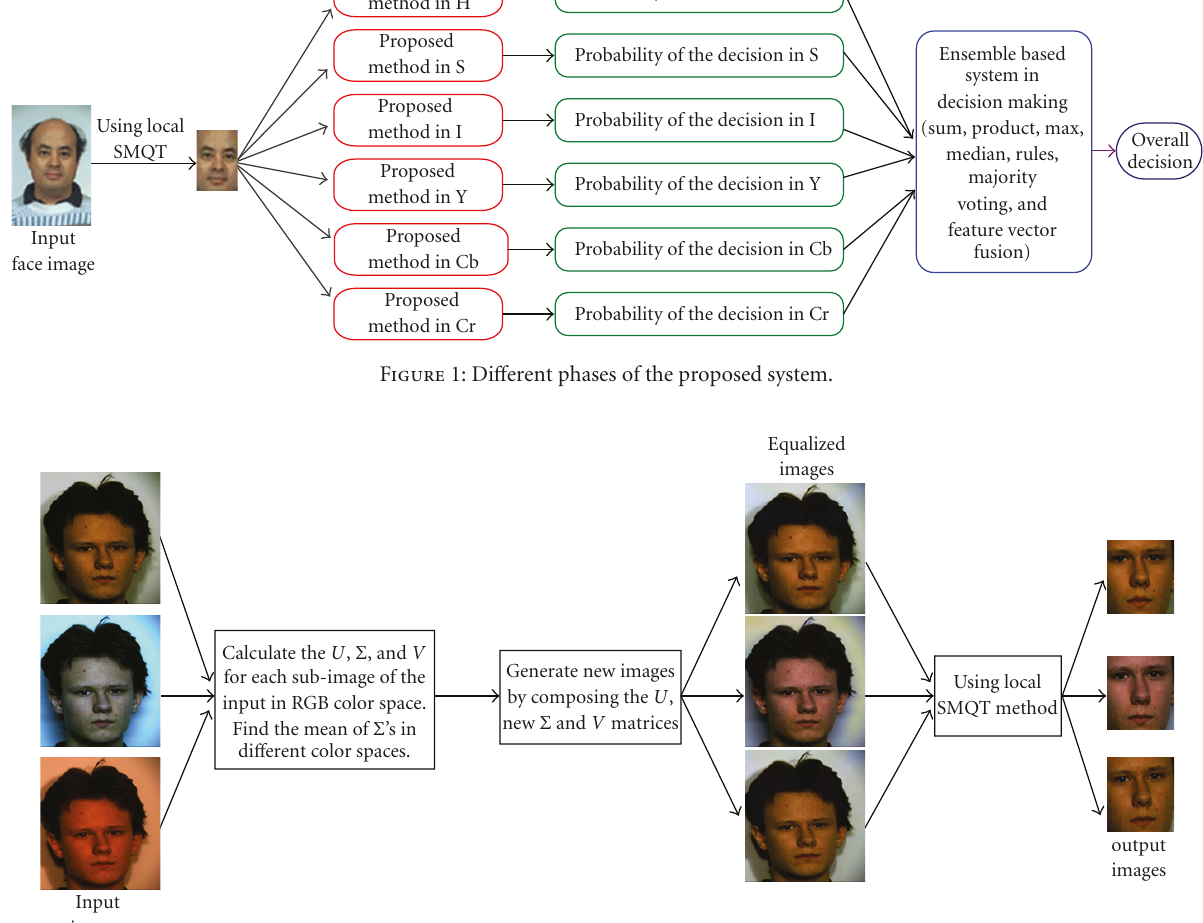
Figure 2: The algorithm, with a sample image with di ff erent illumination from Oulu face database, of pre-processing of the face images to obtain a segmented face from the input face image.